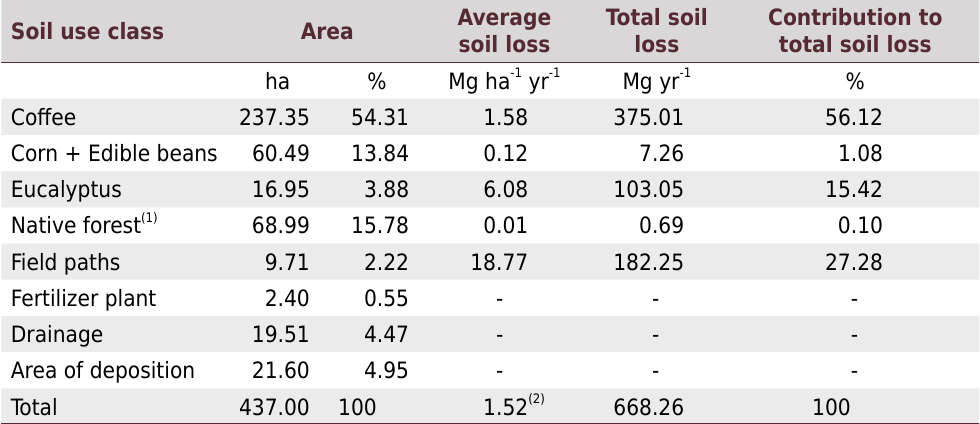
Table 3. Values of potential soil losses only in the soil use